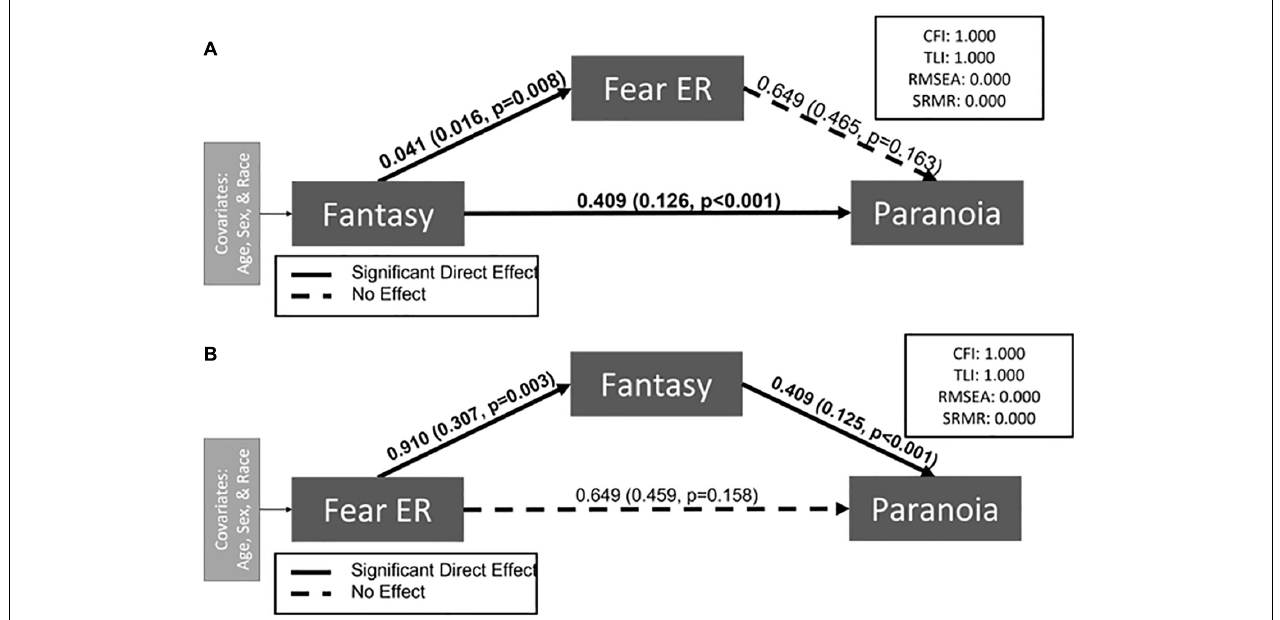
FIGURE 3 | Exploratory path models demonstrate associations between Fantasy, fear recognition, and paranoia. Indirect paths are designated either through fear recognition (A) or Fantasy (B) . Neither model demonstrated a significant indirect effect. The estimate and standard error are presented for each path. Significant paths are indicated with solid black lines and bolded coefficients. Non-significant pathways are indicated with dashed lines. TABLE 3 | Test